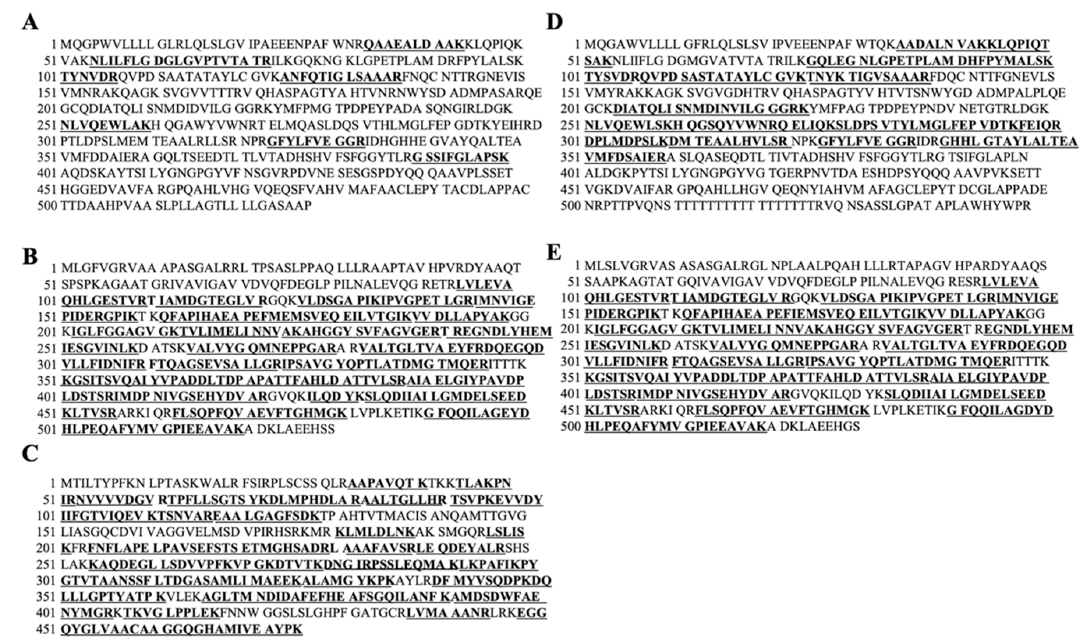
Figure 4. IIXEK-binding amino acid sequences of proteins identified by nano LC-MS/MS analyses. ( A